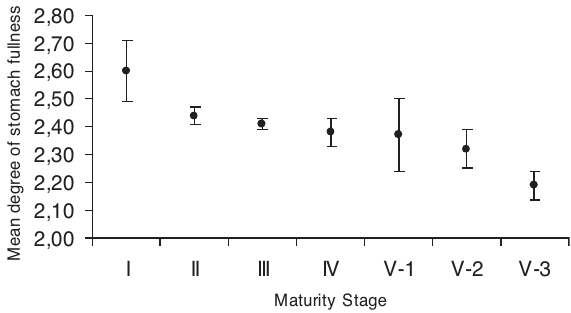
F IG . 7. – Mean degree of stomach fullness at different maturity stages (with 0.05 Confidence level error